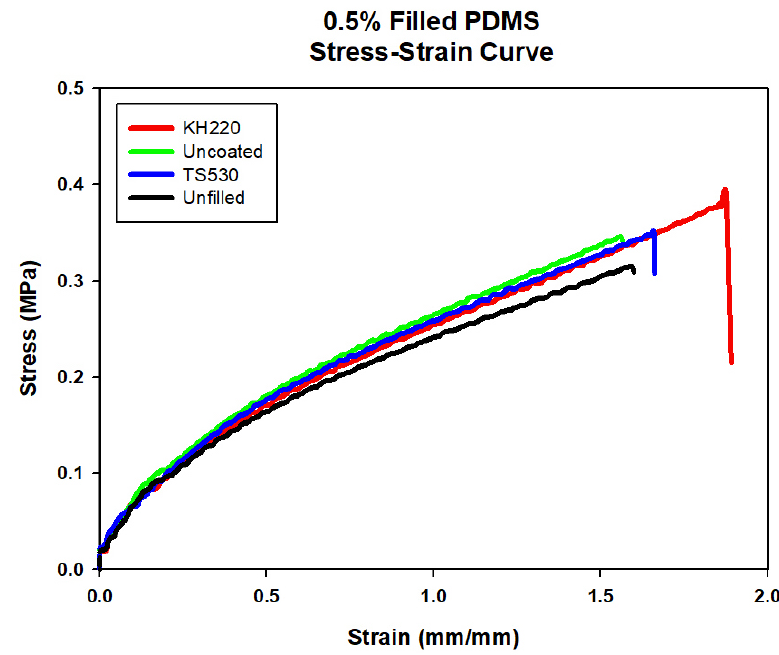
Figure 4. Stress–strain Curve of Unfilled and 0.5% Filled PDMS with Three Filler Types.